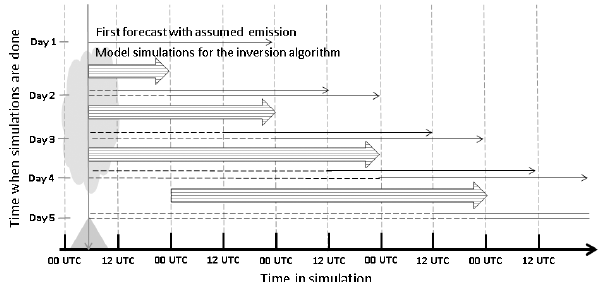
Figure 1. Sequence of model simulations started at the Norwegian Meteorological Institute in the case of a volcanic eruption. The single black arrows indicate 48h forecast simulations. The thick striped arrows represent the multiple model simulations started for the inversion algorithm to retrieve an improved emissions estimate using satellite data. Dashed lines represent spin-up model simula- tions with emissions estimates found by the inversion algorithm. These model simulations are continued as forecasts (single black arrows). The chronological order of simulations starts from the top, so new forecast results are available every 12h. The inversion sim- ulations are restarted every